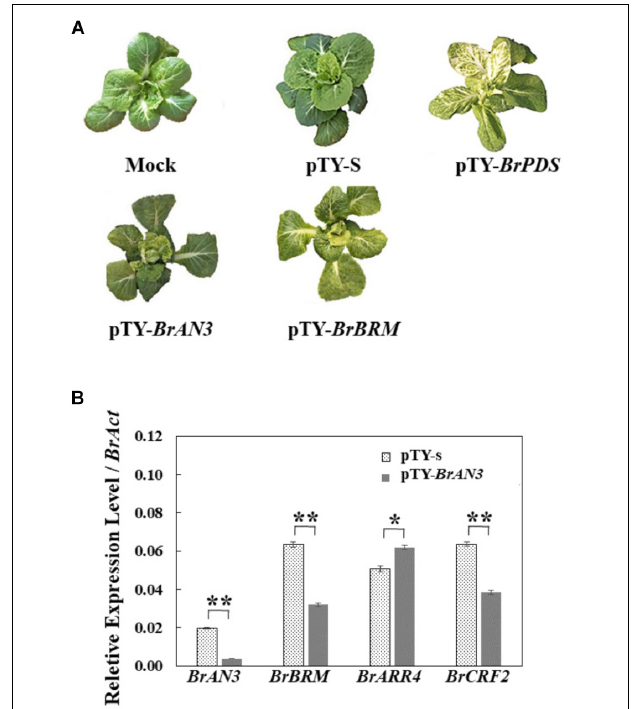
FIGURE 3 | Effects of gene silencing of BrAN3 and BrBRM in Chinese cabbage. (A) Representative images of the silencing plants by using the TYMV-derived vector pTY-S at 60 DPI. A gene-specific fragment of 40 nt in length was selected for each of the two genes to create an in-frame stop codon (TAA, TGA, or TAG) on the second, third or fourth amino acid position on each fragment due to frame shift. The gene-specific fragment was selected to target all the homologous sequences of each gene in the Chinese cabbage genome. Six weeks old Chinese cabbage plants were inoculated with each gene silencing vector. The mock treatment and the empty vector pTY-S were used as the negative control, while the pTY- BrPDS was used as the positive control. Leaf head formation was observed for pTY- BrAN3 and pTY- BrBRM -inoculated plants. (B) Relative expression levels of BrAN3 , BrBRM , and two of BrAN3 downstream genes BrARR4 and BrCRF2 in the BrAN3 -silencing plants measured by Real-time RT-PCR. RNA was extracted from the BrAN3 -silencing leaves with the empty vector pTY-S-inoculated leaves as the control at 60 DPI. Relative expression levels were calculated using the standard curve method with BrAct ( Bra028615 ; Dheda et al., 2004) as the internal control gene. Bars represent the means of three replicates ± standard errors (vertical bars). Asterisks indicate a significant difference between the two stages at p ≤ 0.05 as calculated by t -test.